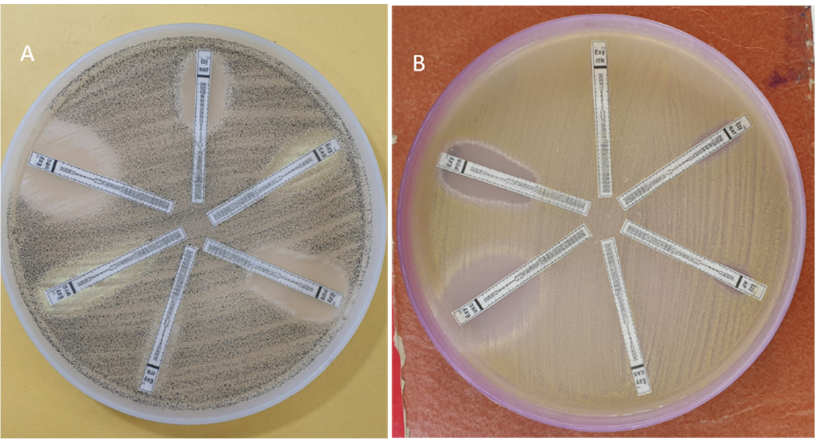
Figure 5. Anti-fungal susceptibility testing using E test in ( A ) Aspergillus niger ( B ) Aspergillus